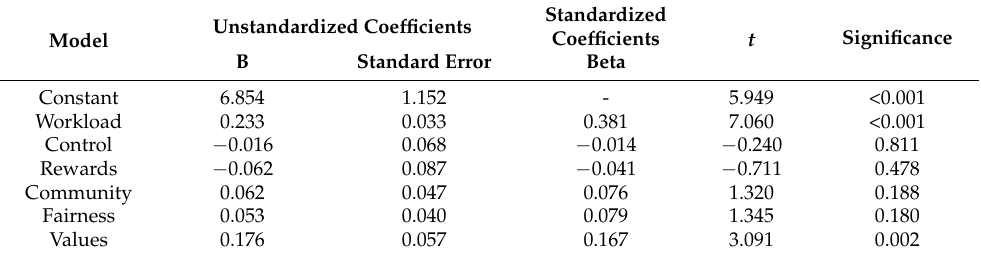
Table 4. Emotional exhaustion and areas of work life.